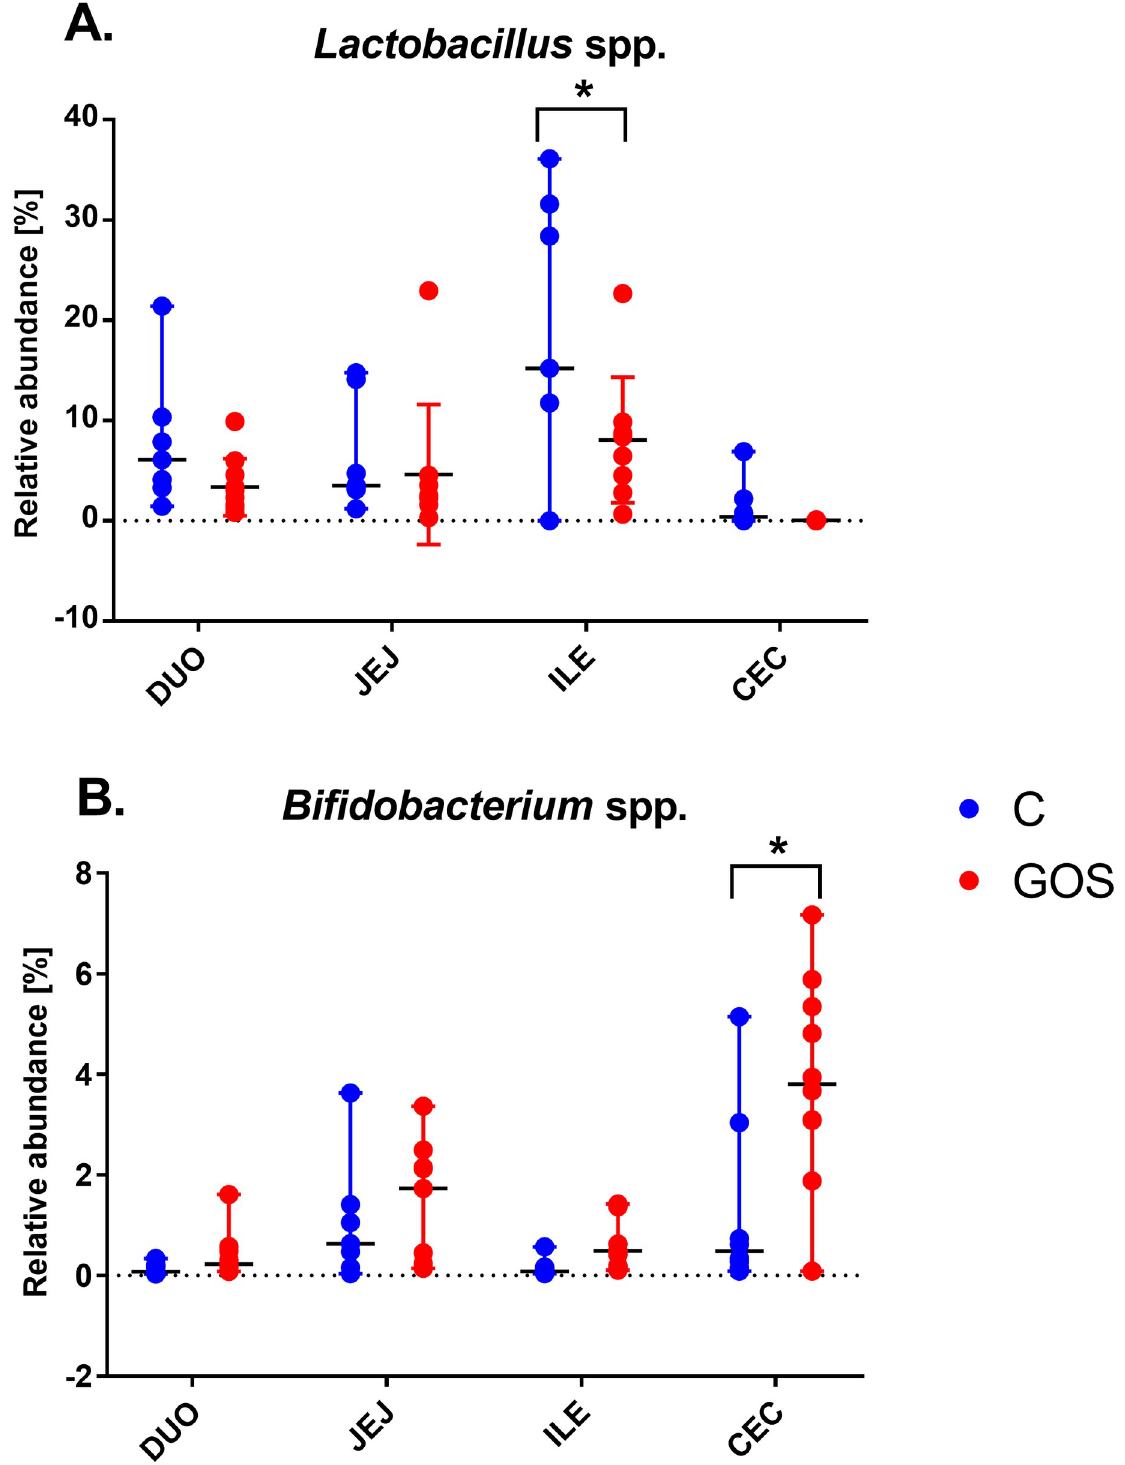
Fig 1. The relative abundance of Bifidobacterium spp. (A) and Lactobacillus spp. (B) in chyme from different sections of GIT in chickens supplemented in ovo with GOS prebiotic. GOS was delivered in ovo on day 12 of egg incubation. Samples of intestinal content were collected from 42-days-old chickens. Intestinal content was sampled from four distinct intestinal segments (duodenum, jejunum, ileum, and caecum) (n = 10). Bacteria quantification was done with qPCR based on bacterial DNA isolated from chyme. Statistical analysis was performed with two-way ANOVA with a Tukey HSD post hoc test. Significant differences found at P < 0.05. https://doi.org/10.1371/journal.pone.0212318.g001 PLOS ONE | https://doi.org/10.1371/journal.pone.0212318 February 27,